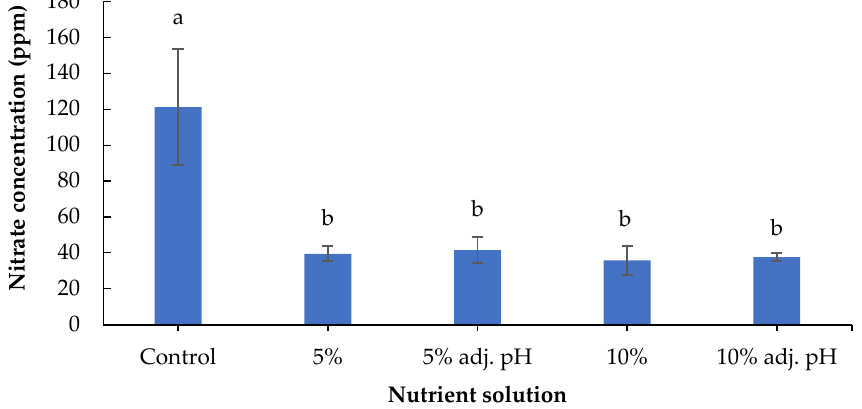
Figure 5. Nitrate content of baby lettuce leaves grown in a floating hydroponic system under different dilutions in water during the winter period. Columns (means ± SE) with different letters are significantly different ( p < 0.05).